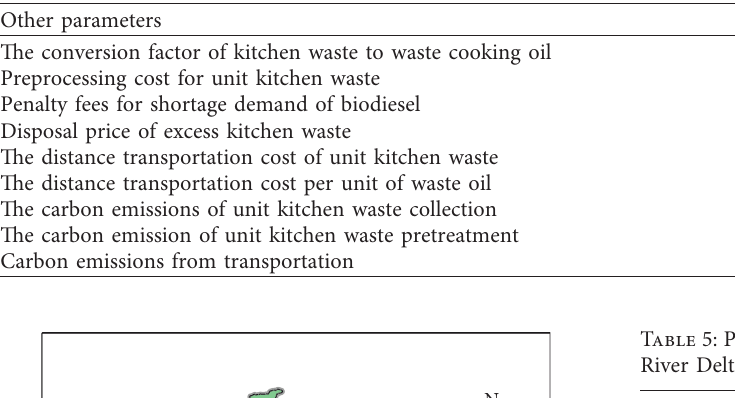
Table 4: Other parameters.